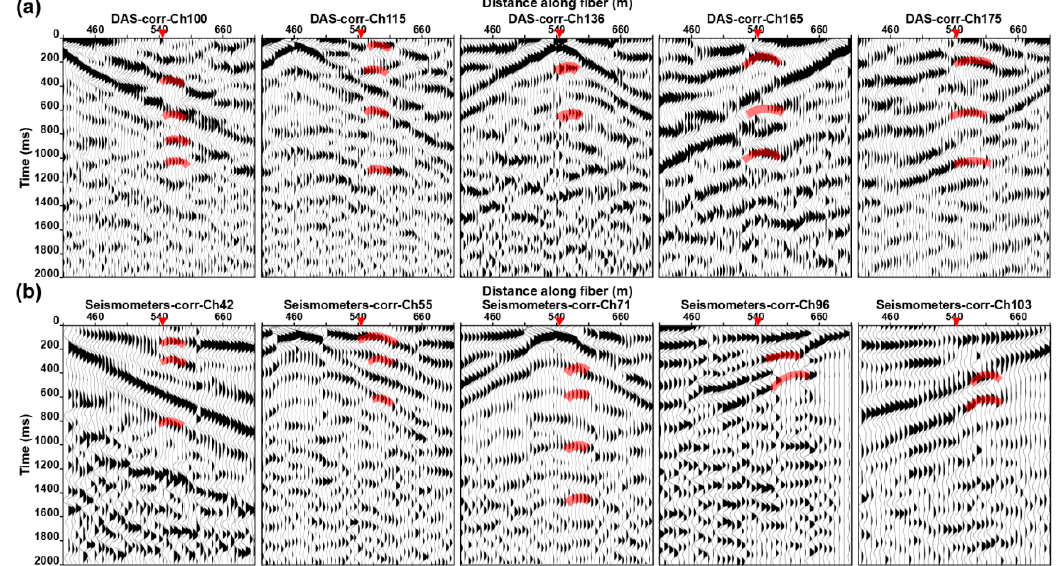
Figure 8. Examples of the multi-offset CC result based on 5 h DAS ( a ) and nodal seismometers data ( b ), respectively. The virtual source point is located near active fault. data ( b ), respectively. The virtual source point is located near active